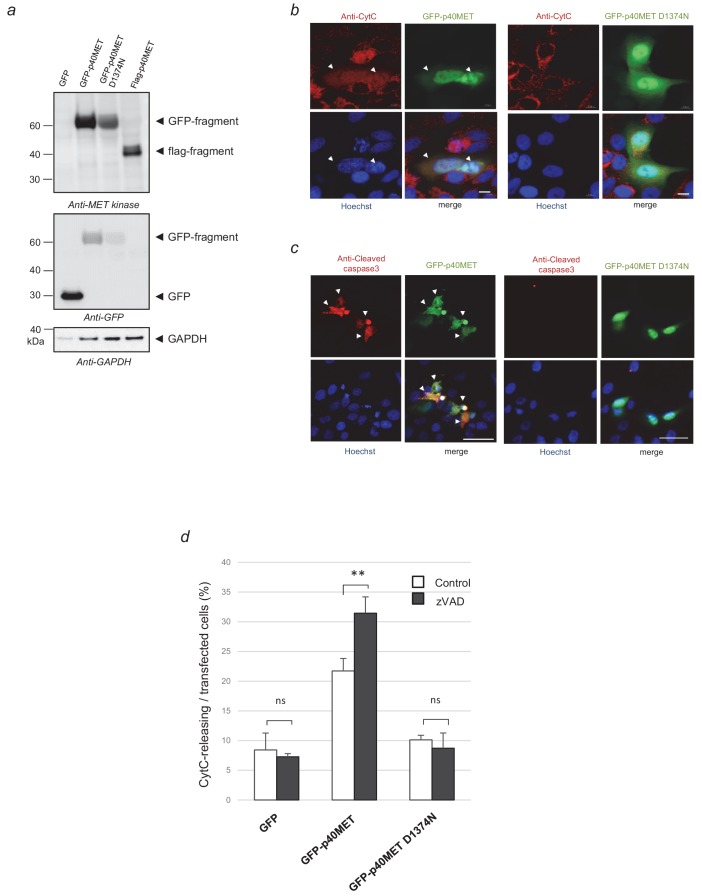
Validation of the vectors expressing GFP-p40MET and GFP-p40MET D1374N.(a) HEK 293 cells were transfected with a vector expressing GFP, GFP-p40MET, GFP-p40MET D1374N or Flag-p40MET. Twenty-four hours after transfection, the cells were lysed. The protein mixture was resolved by 4–12% SDS-PAGE and analyzed by western blotting with antibodies against the MET kinase domain, GFP, and GAPDH. (b–c) Representative pictures of transfected cells immuno-labeled with a cytochrome-c (b) or cleaved-caspase 3 antibody (c) are shown. White arrowheads indicate transfected cells positive for cytochrome-c release or cleaved caspase 3; scale bars = 10 µm (b) and 50 µm (c). (d) MCF10A epithelial cells were transiently transfected with a vector expressing GFP, GFP-p40MET or GFP-p40MET D1374N and treated with zVAD (20 µM). Twenty-four hours after transfection, the cells were fixed and labeled with anti-cytochrome C antibody. The percentage of cells displaying cytochrome C release was determined with respect to the number of GFP-positive cells. At least 60 cells were counted per well (n = 3; mean ± S.D; **p<0.01 as determined by Student’s t test).